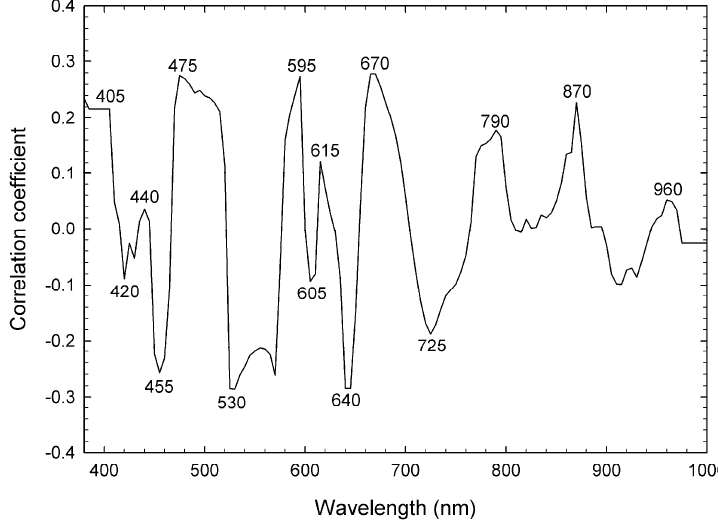
Figure 4. Correlative coefficients between the chlorophyll degradation velocity and reflectance at 5 nm wavelength bands between 380 and 1000 nm.